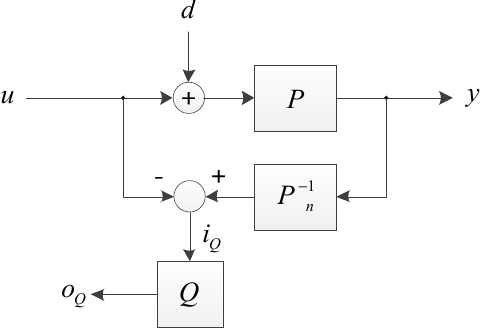
Figure 3. Conventional disturbance observer (DOB).